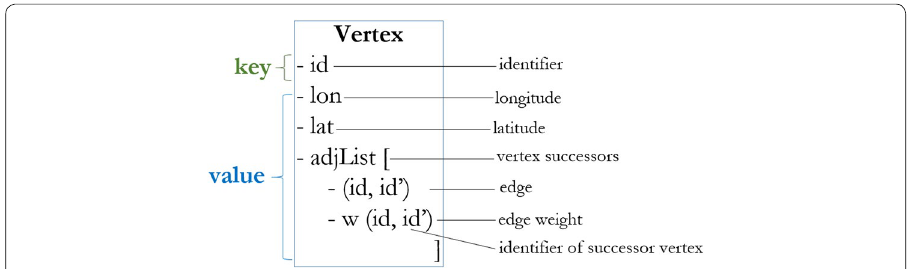
Fig. 4 Overview of vertex structure. Each vertex is identified by a unique key and all connected edges are enclosed in the adjList